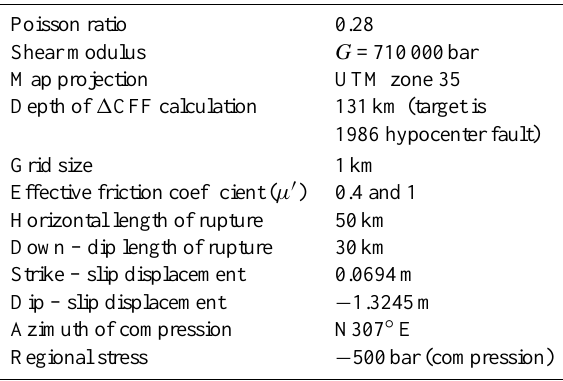
Table 3. Input parameters used for stress transfer modeling of the 1977 earthquake ( M = 7 . 4).